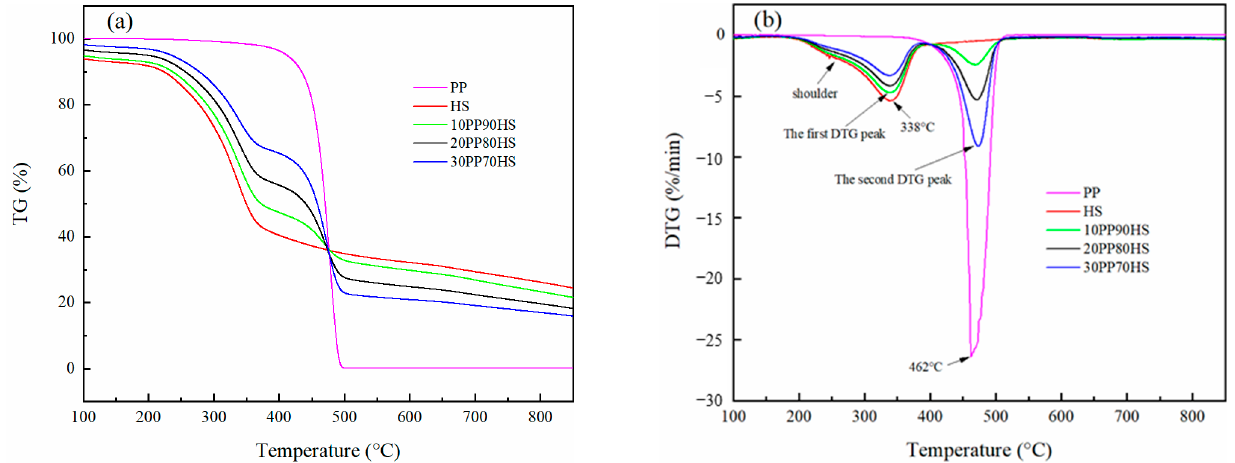
Figure 1. ( a ) TG and ( b ) DTG curves of HS, PP, and their blends pyrolyzed at 10 °C·min − 1 (the number preceding the abbreviated letters represents the material content in blends).